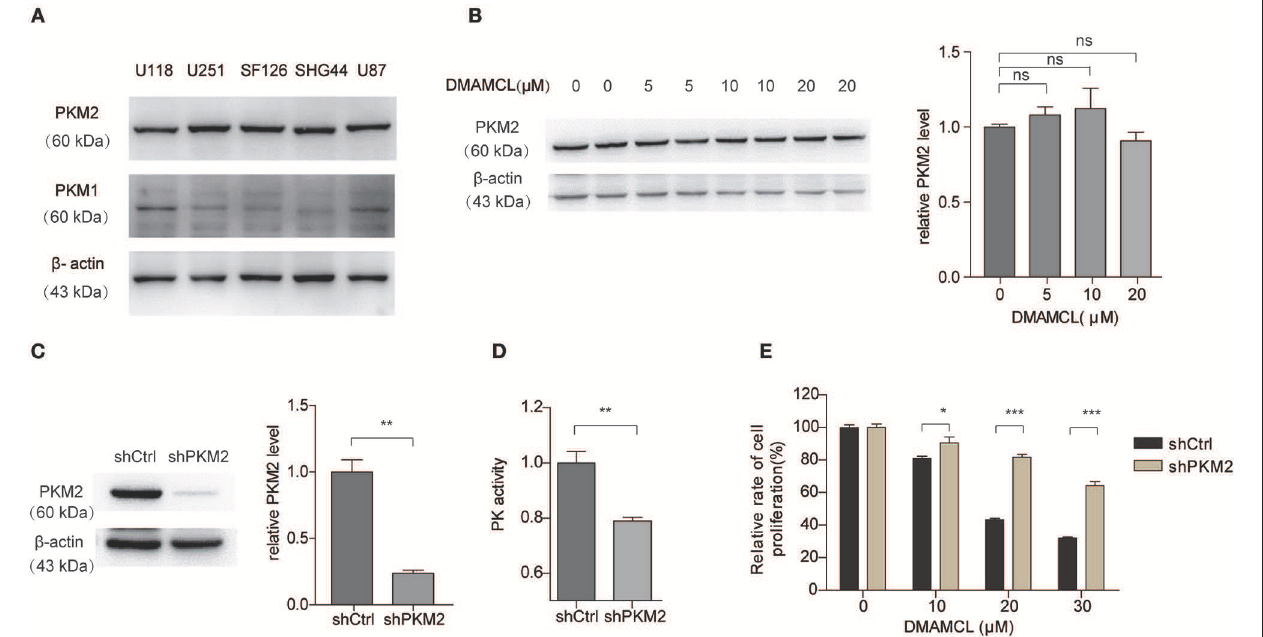
FIGURE 5 | The cell viability inhibition effect of DMAMCL is dependent on the expression of PKM2. (A) Western blot detection of PKM2 and PKM1 in different human glioma cell lines. (B) The expression of PKM2 with DMAMCL treatment was detected via western blot. (C) The depleted expression of PKM2 was confirmed by western blotting. (D) The PK activity of U251MG cells was detected with sh Ctrl and sh PKM2 by PK activity assay. (E) Depleted expression of PKM2 resulted in a decreased inhibition effect of DMAMCL in U251MG cells after treatment for 48h. Cell viability was determined by CCK8 assay. Error bars, mean ± s.e.m., n = 3